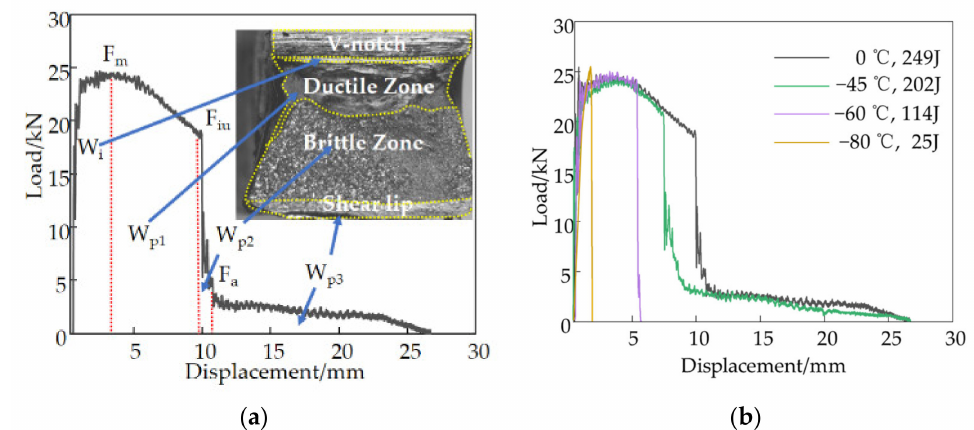
Figure 6. ( a ) The standard load-displacement curve of the instrument impact test; ( b ) The load- displacement curve of H II at different temperatures. F m —the maximum force; W i —crack initiation energy; F iu —brittle crack initiating force; W p1 —stable crack propagation energy; W p2 —unstable crack propagation energy; W p3 —shear lip energy.